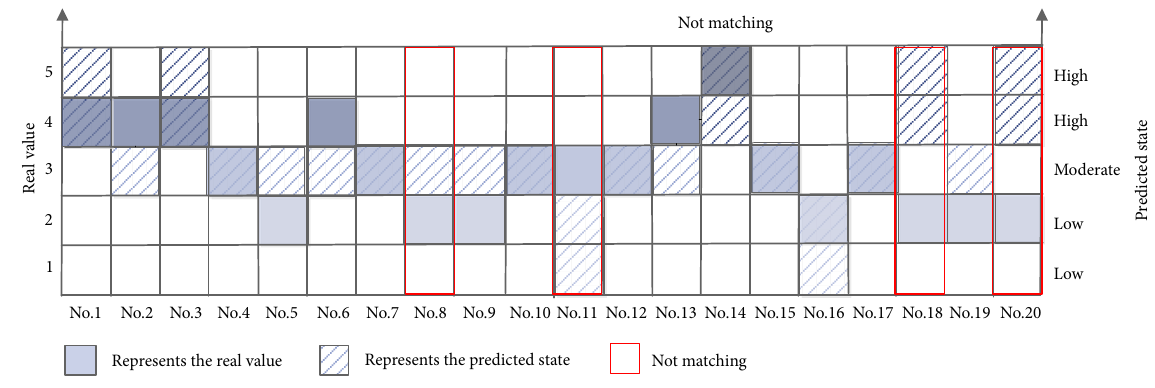
Figure 5. Comparison of the predicted state and real value for the 20 test samples